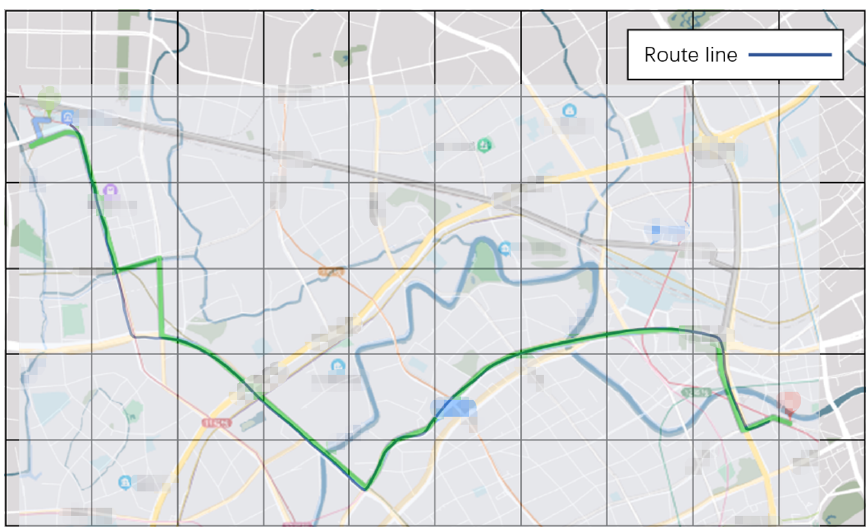
Figure 10. Comparison of the result.